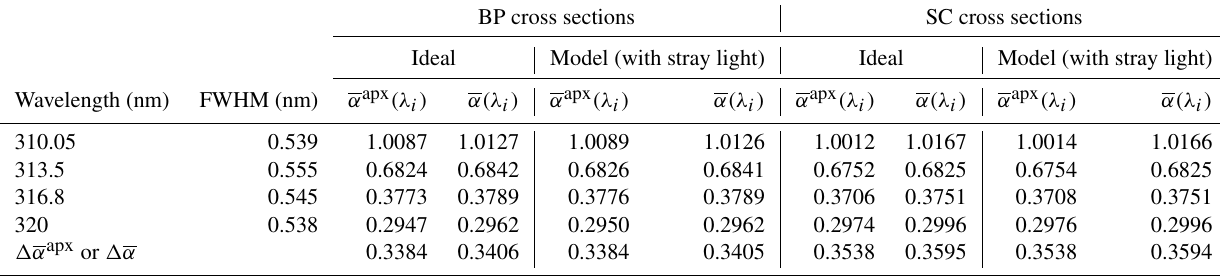
Table 5. Double Brewer ozone absorption